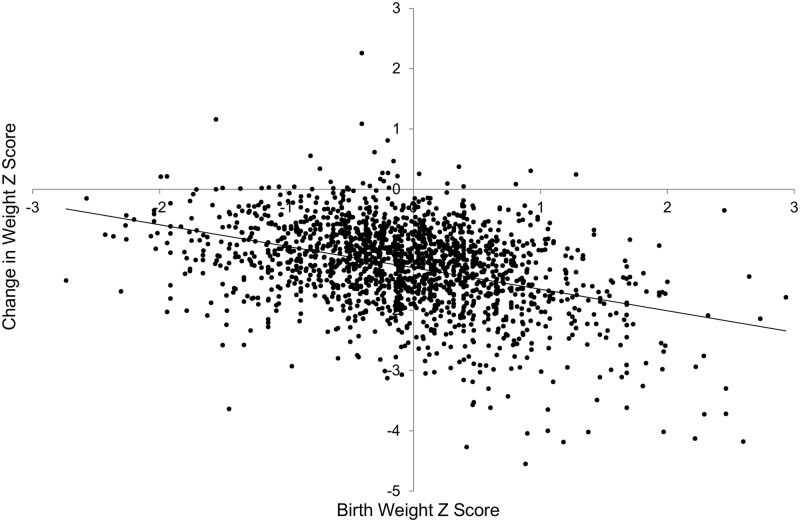
Change in weight Z score from birth to discharge vs. birth weight Z score for the reference NICU (Mount Sinai).Regression line: y = -0.387x-0.980, R2 = 0.192 (p<0.001).